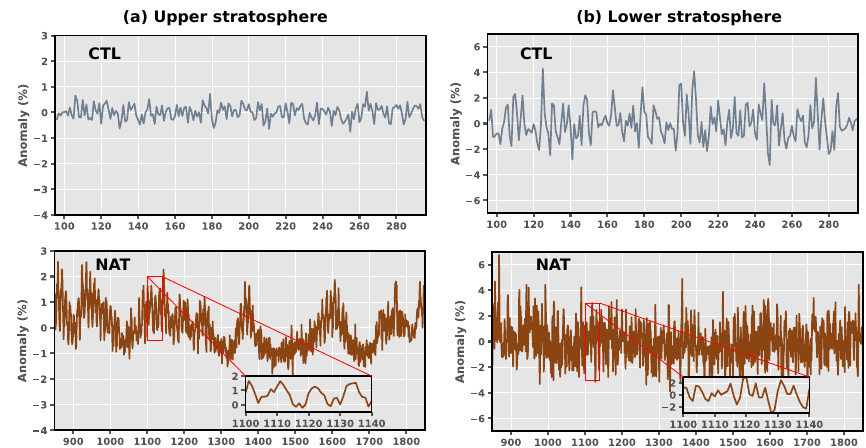
Figure 2. Same as Fig. 1 but for ozone anomalies from the preindustrial control simulation (top) and the preindustrial natural simulation (bottom) for the upper (a) and lower stratosphere (b) . The NAT results show (as an inset) an expanded 40-year segment of the anomaly data.